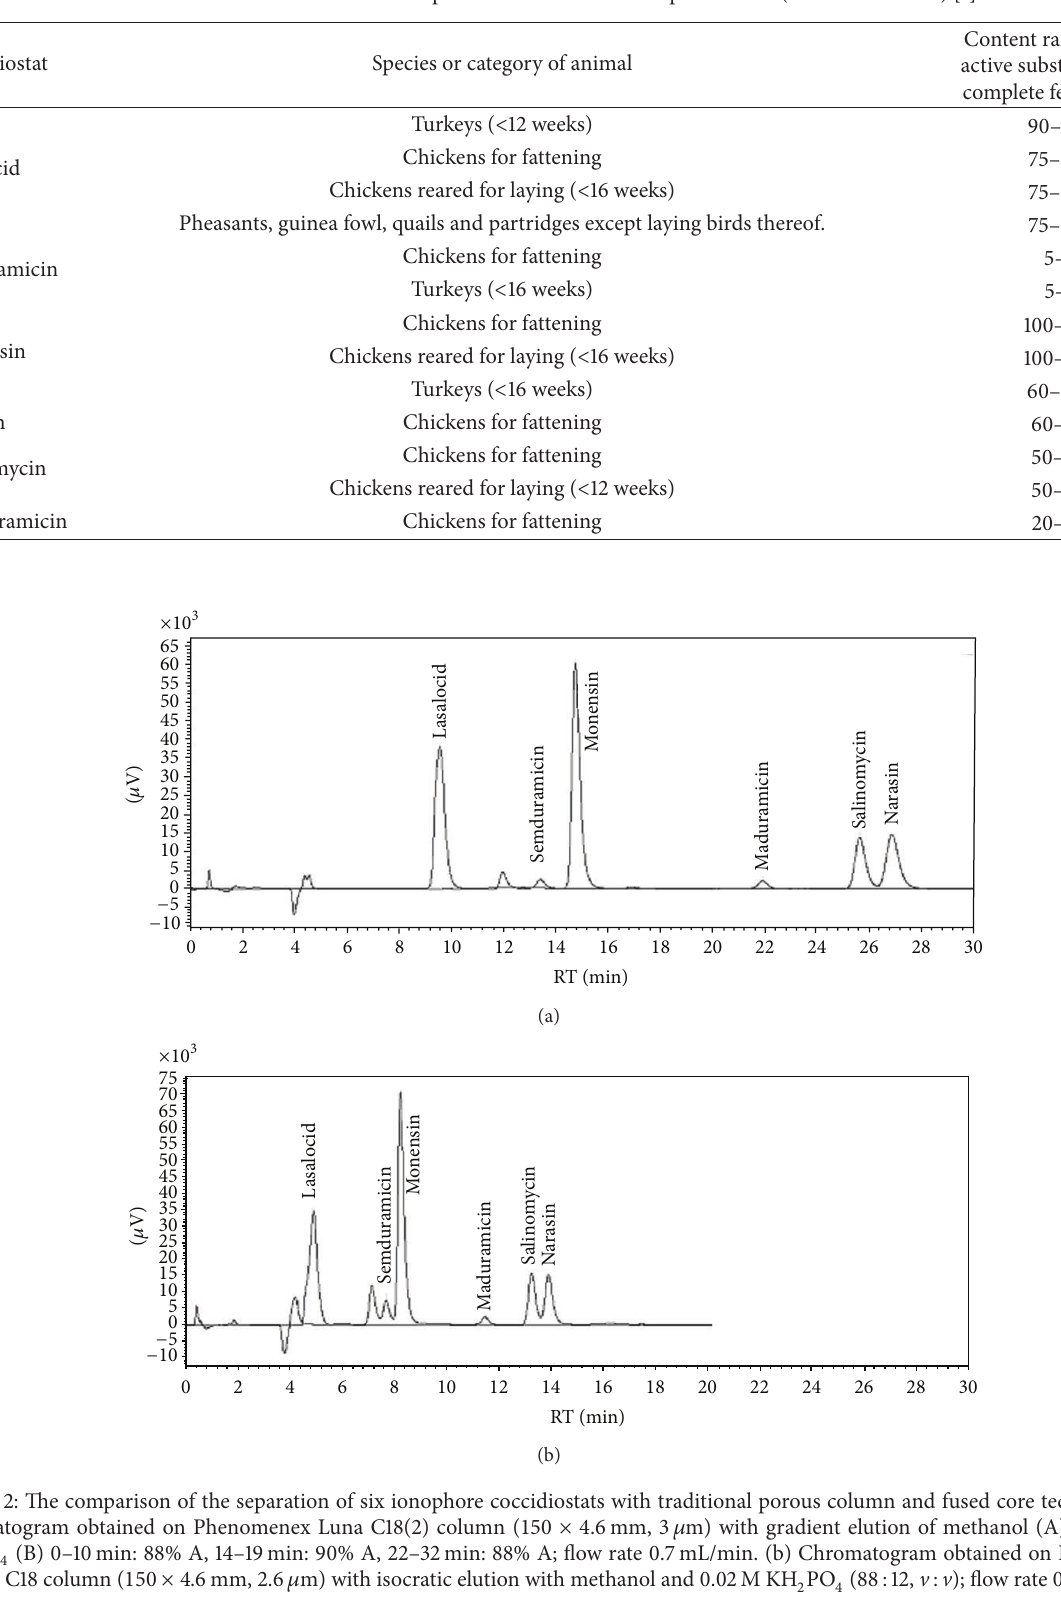
Table 1: The authorization of ionophore coccidiostas in European Union (as for 09/04/2013) [1].